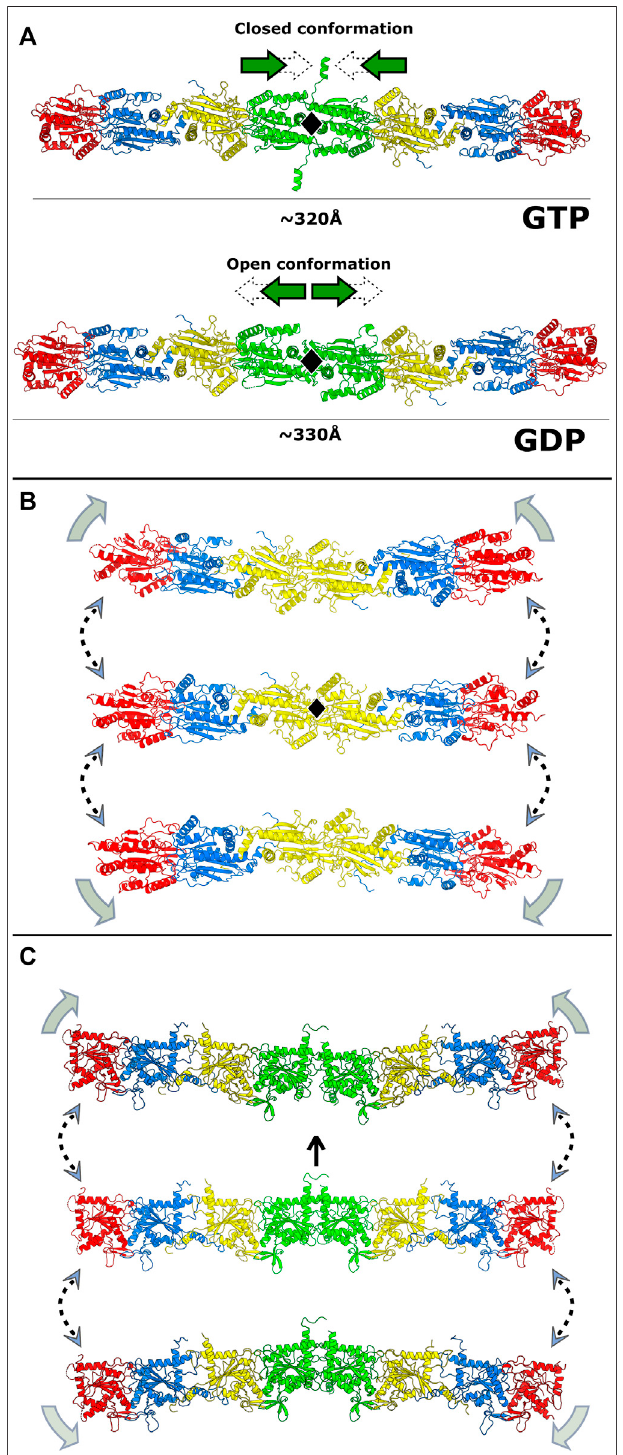
FIGURE 14 | Intrinsic fl exibility of the fi lament. (A) The proposed concertina movement of the octamer due to the opening and closing of the central SEPT3-group NC-interface. In this case, the twofold symmetry is preserved. (B) Flexion of the hexamer around the twofold axis between the two copies of SEPT7 at the center (yellow) present in the cryo-EM model